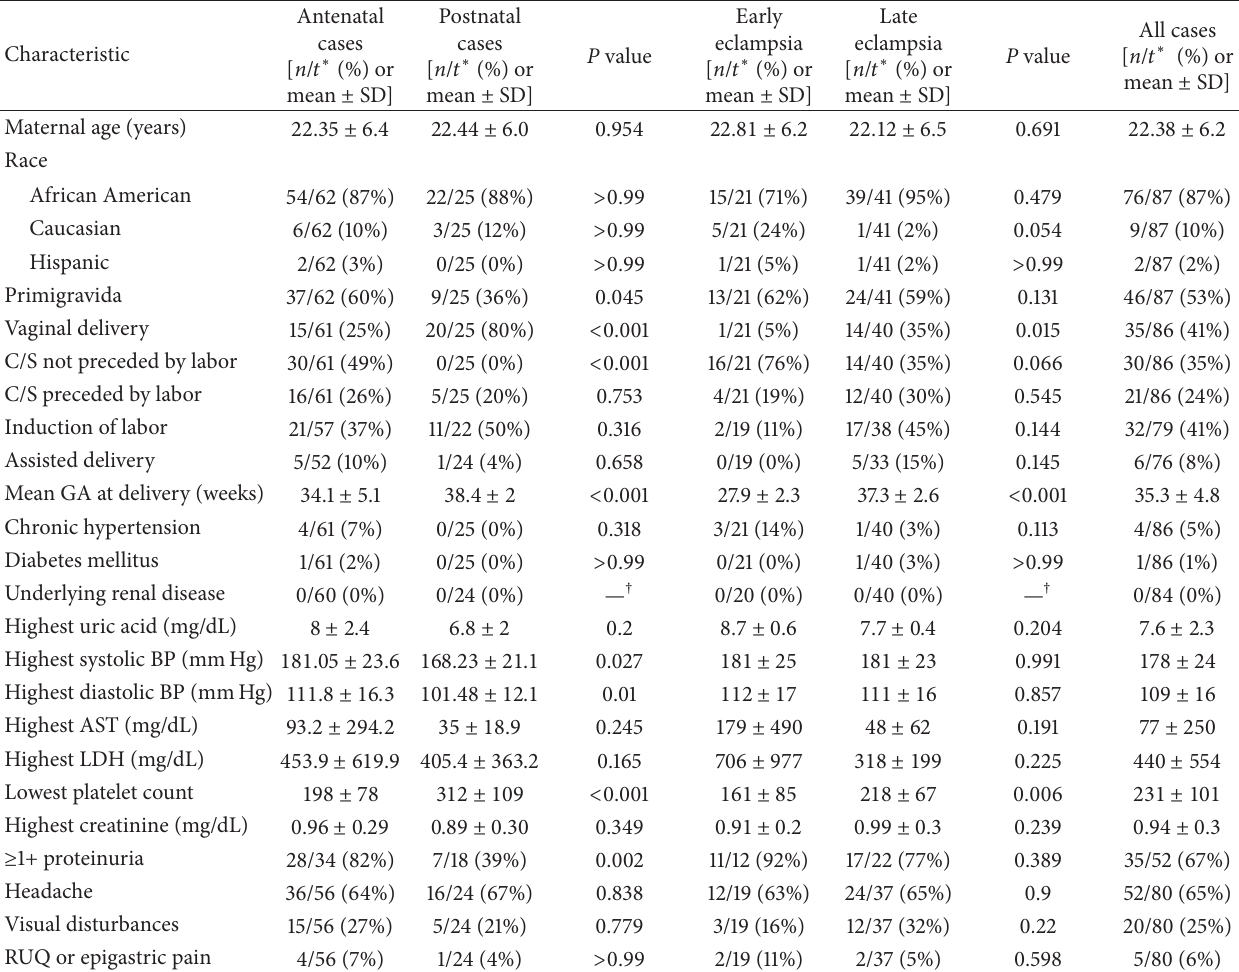
Table 1: Characteristics of eclampsia